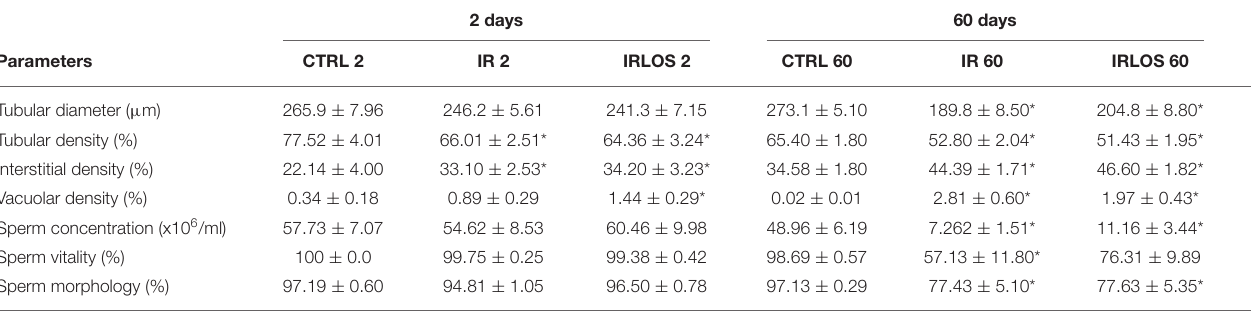
TABLE 2 | Tubular diameter, density of the seminiferous tubules, interstitial tissue, and vacuoles in testicular parenchyma, and sperm evaluation of the animals of each experimental group after 2- and 60-days of the exposure. 2